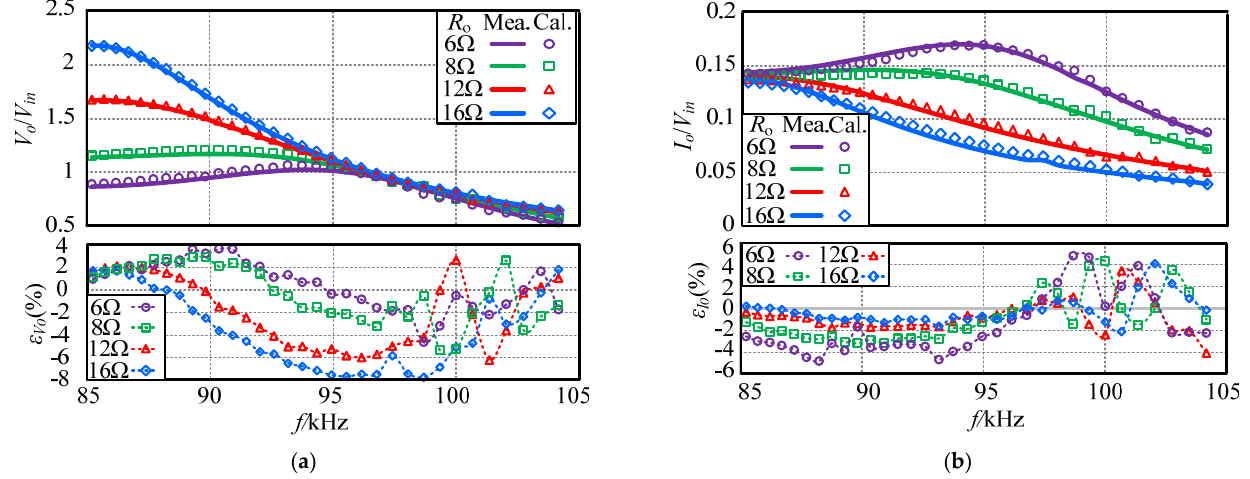
Figure 15. Identification results of the ( a ) output voltage and ( b ) output current at various frequencies and load resistances.